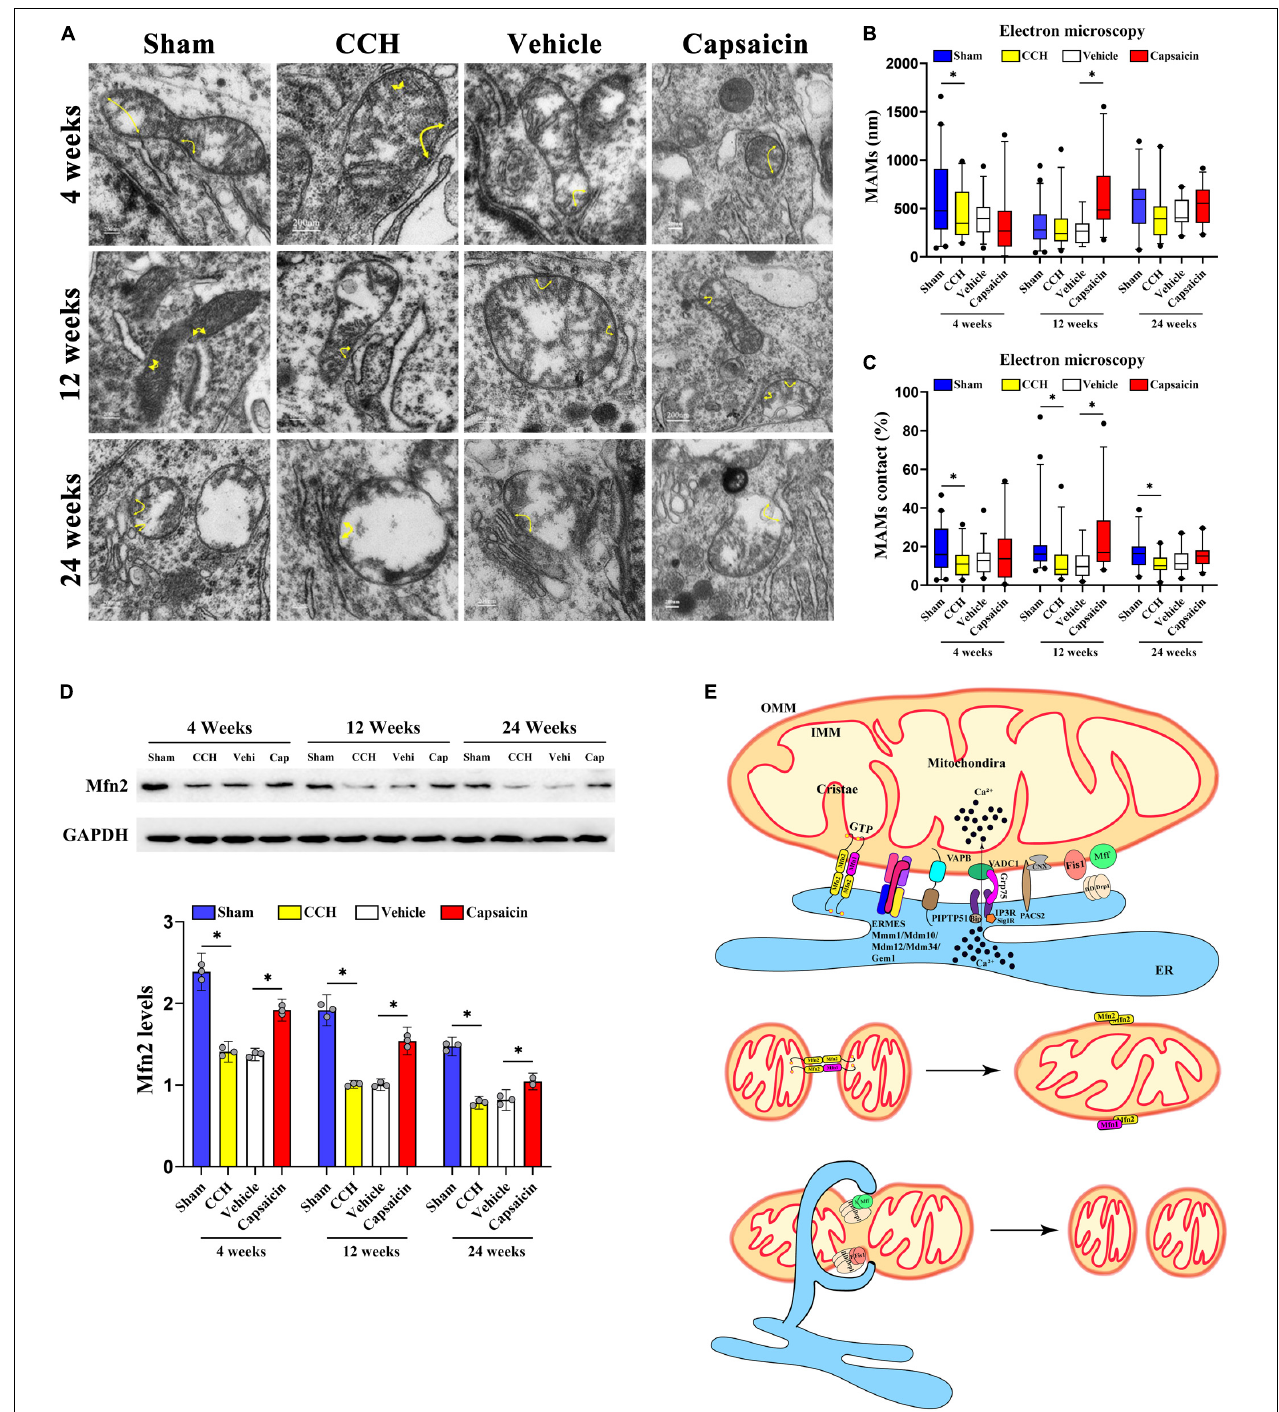
FIGURE 2 | Capsaicin rescues loosened ER-mitochondria contacts in the hippocampal CA1 region of CCH rats. (A) Representative electron micrographs of ER-mitochondria contacts at each time point in each group. Yellow arrowheads with loops show regions of contact. Scale bar = 200 nm (20000x). (B) Boxplot showing the length of the mitochondrial surface closely contacted with the ER ( < 30 nm) at different time points. (C) The proportion of ER-mitochondrial contacts relative to the mitochondrial circumference. (D) Scatterplot showing the relative MFN2 levels. (E) Schematic drawing of MAMs. The components mainly included the MFN2 homodimer; the MFN1/2 heterodimer; endoplasmic reticulum mitochondria encounter structure (ERMES) composed of Mdm10/34/12, Mmm1 and Gem1; and VAMP-associated protein B (VAPB) interacting with PTPIP51. Data were analyzed by one-way ANOVA followed by the post hoc LSD test (data obtained from 100 to 124 mitochondria). Data are presented as the mean ± SD. ∗ P < 0.05.